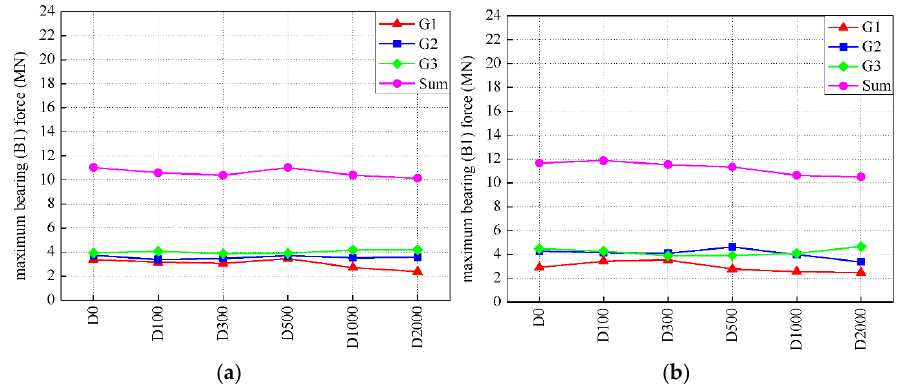
Figure 13. Maximum bearing (B1) forces in tangential direction. ( a ) Stopper = 4 cm. ( b ) Stopper = 8 cm.